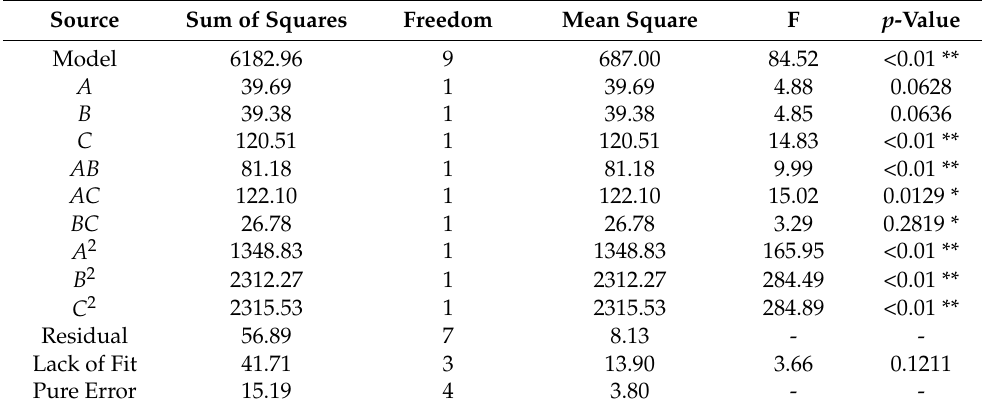
Table 8. Tool shaft torque analysis of